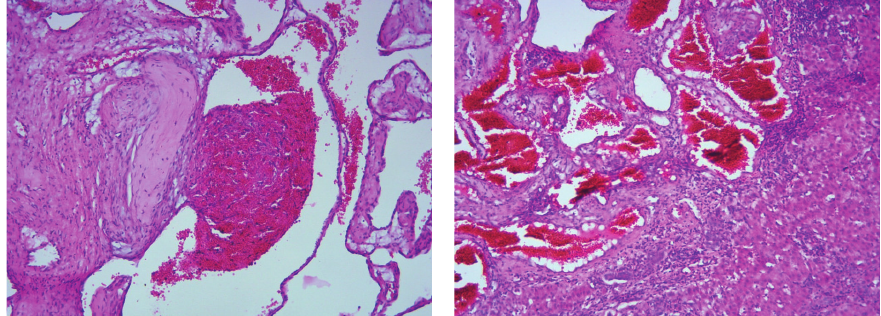
number of lesions, and growth pattern of the hemangioma [4, 13, 14]. Enucleation without a margin of normal liver parenchyma is a justified treatment, since hemangiomas are benign lesions. The advantages of enucleation are less intra- operative blood loss (enucleation: 400 mL versus resection: 1330 mL; 𝑝 = 0.004 ), less risk of bile leakage (enucleation: 0% versus resection: 8–17%), maximum preservation of functional liver parenchyma, and less overall complications [7,